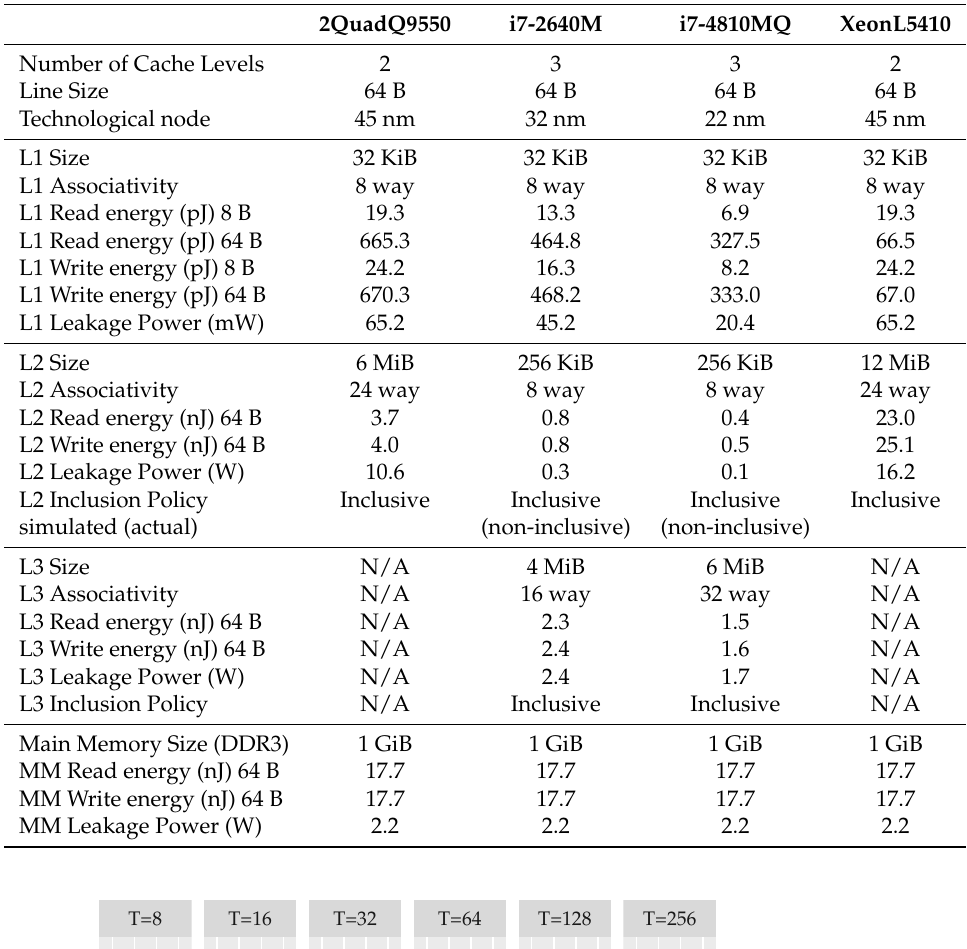
Table 2. Memory subsystem parameters of the four platforms.